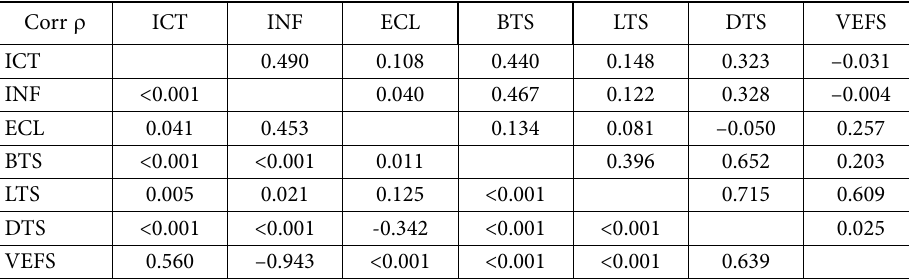
Table 4. Correlation analysis: Spearman’s